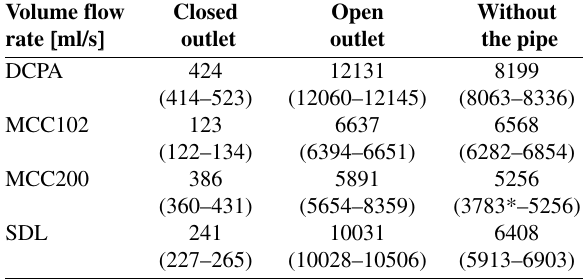
Table 4. Volume flow rates in closed outlet, open outlet condition, and the condition without the pipe as measured 700 mm below